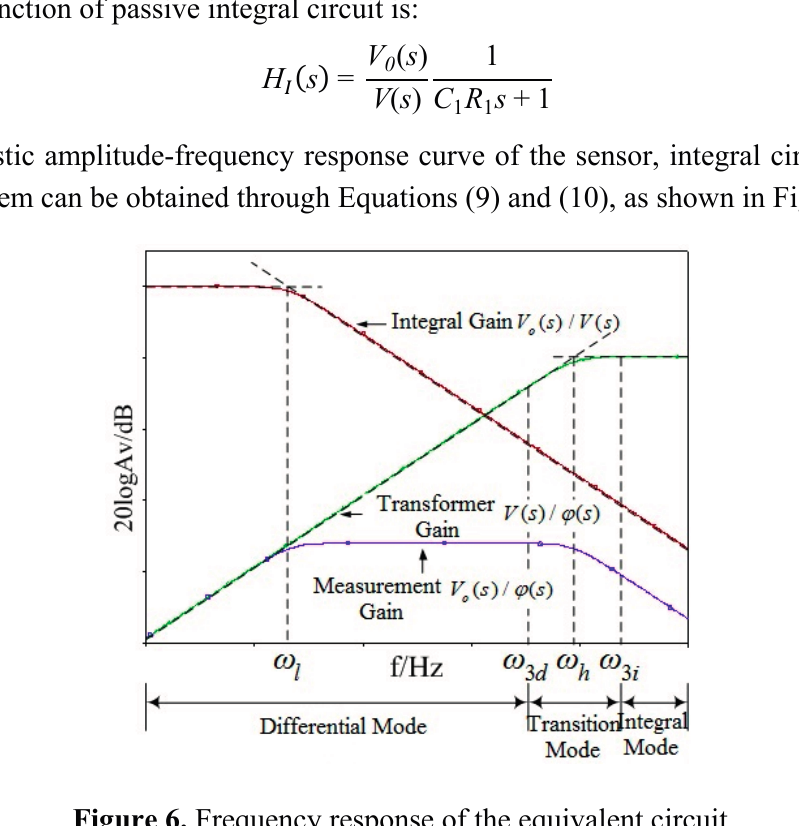
Figure 6. Frequency response of the equivalent